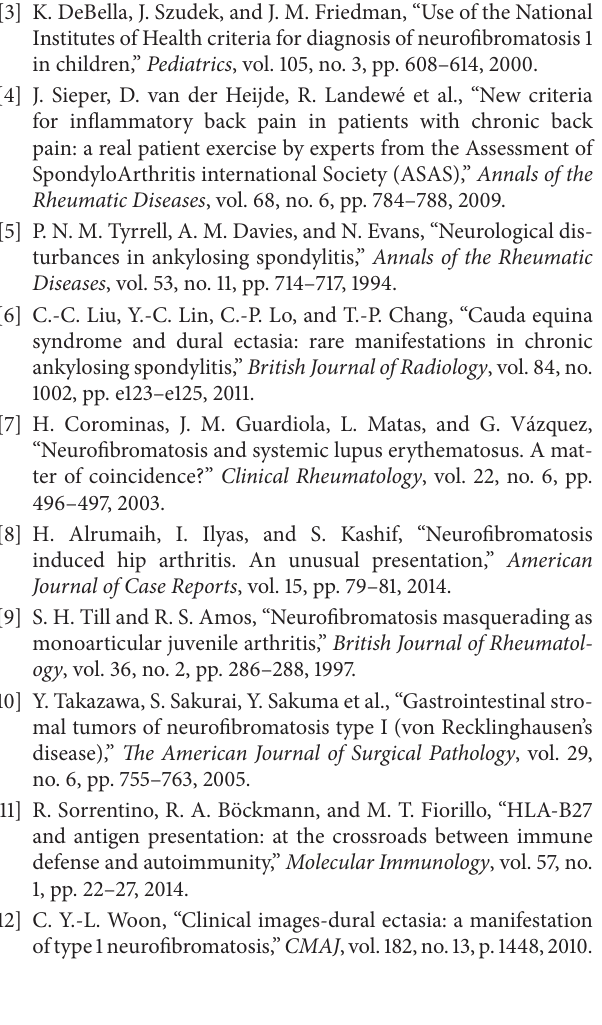
Figure 3: Pelvic X-ray showing bilateral grade III-IV sacroiliitis.